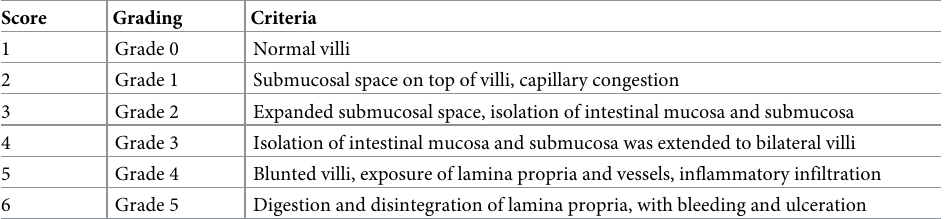
Table 1. Criteria for Chiu’s intestinal mucosal